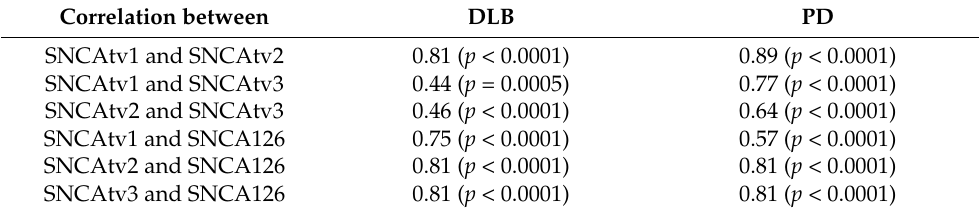
Table 5. Correlation SNCA transcript variant expression in blood of DLB and PD patients.